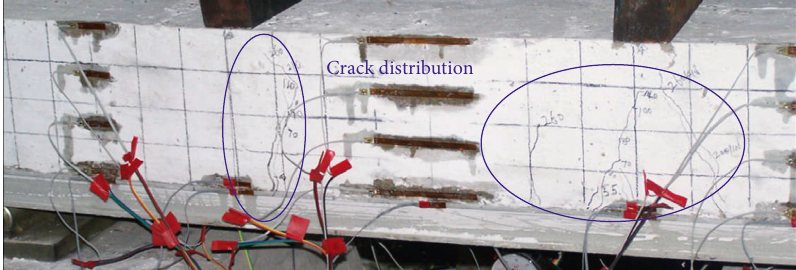
Figure 5: Experimental setup (mm).